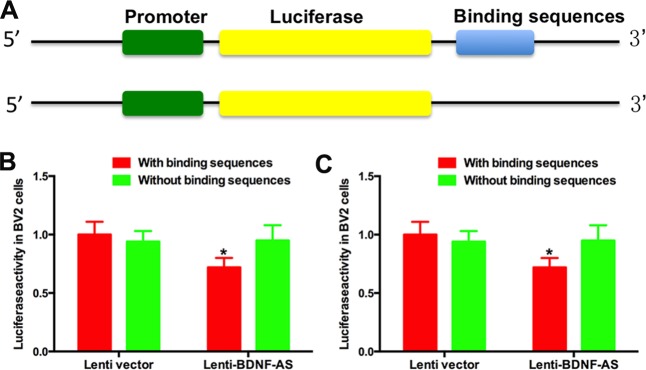
BDNF-AS targets the binding sequence of BDNF mRNA.(A) Luciferase reporter vectors were constructed. (B) In BV-2 cells, the cells were co-transfected with aluciferase reporter vector and Renilla vector and then transduced with lentiviral vectors. When the cells were transfected with the reporter vector containing the binding sequences, lenti-BDNF-AS significantly decreased the luciferase activity. However, in the cells transfected with the reporter vector without the binding sequences, there was no significant difference between the lenti-BDNF-AS and empty vectors. (C)Similar results were observed in RGCs. P<0.05 was considered significantly different; * vs control group.